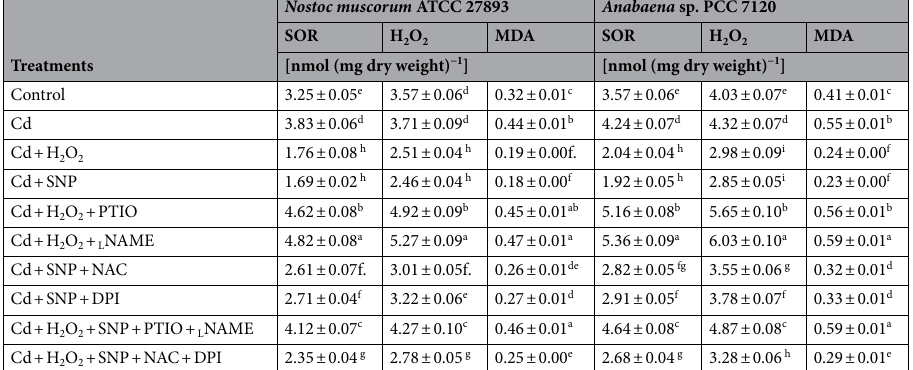
Table 1. Effect of H 2 O 2 and NO (SNP) on the contents of SOR, H 2 O 2 and MDA equivalents in Nostoc muscorum ATCC 27893 and Anabaena sp. PCC 7120 exposed to Cd after 24 h of treatment. Data are means ± standard error of three independent experiments with three replicates in each experiment (n = 9). Bars with different letters show significant difference at P < 0.05 significance level according to the Duncan’s multiple range